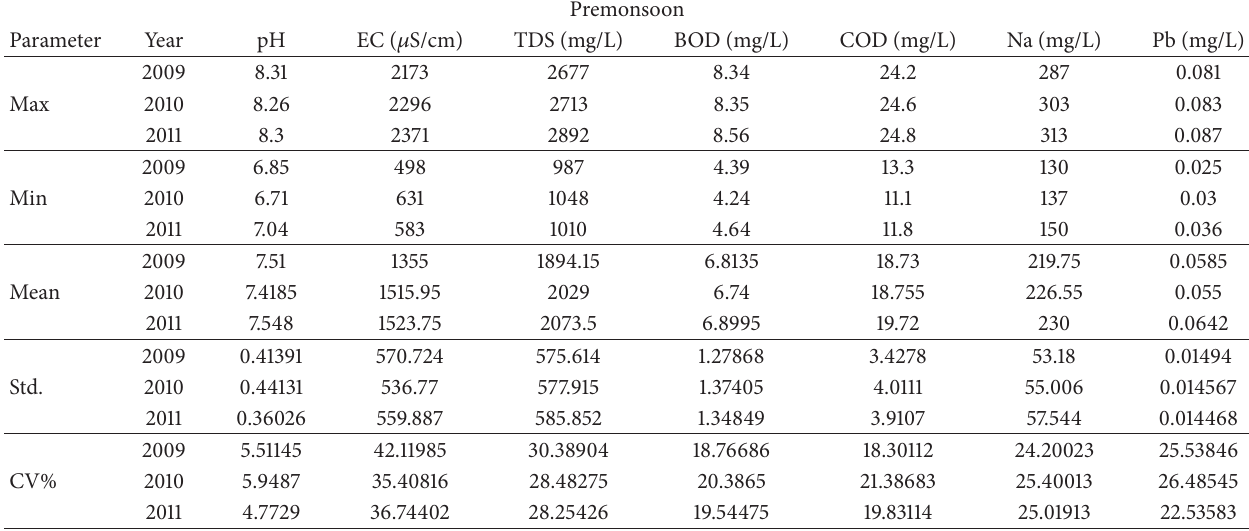
Table 5: Statistics of three years (2009–2011) groundwater quality data—premonsoon.